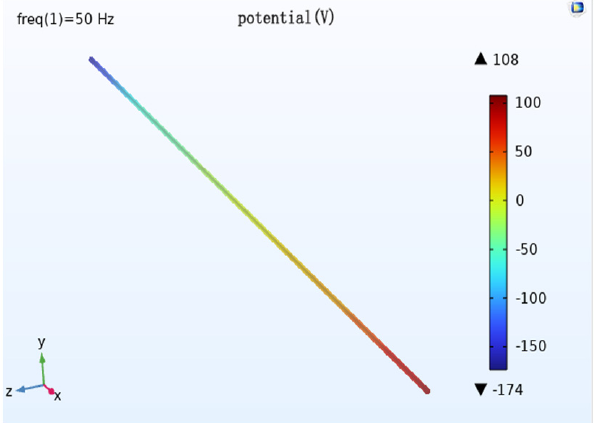
Figure 8. Distribution of cathodic protection potential at voltage level 1000 kV.